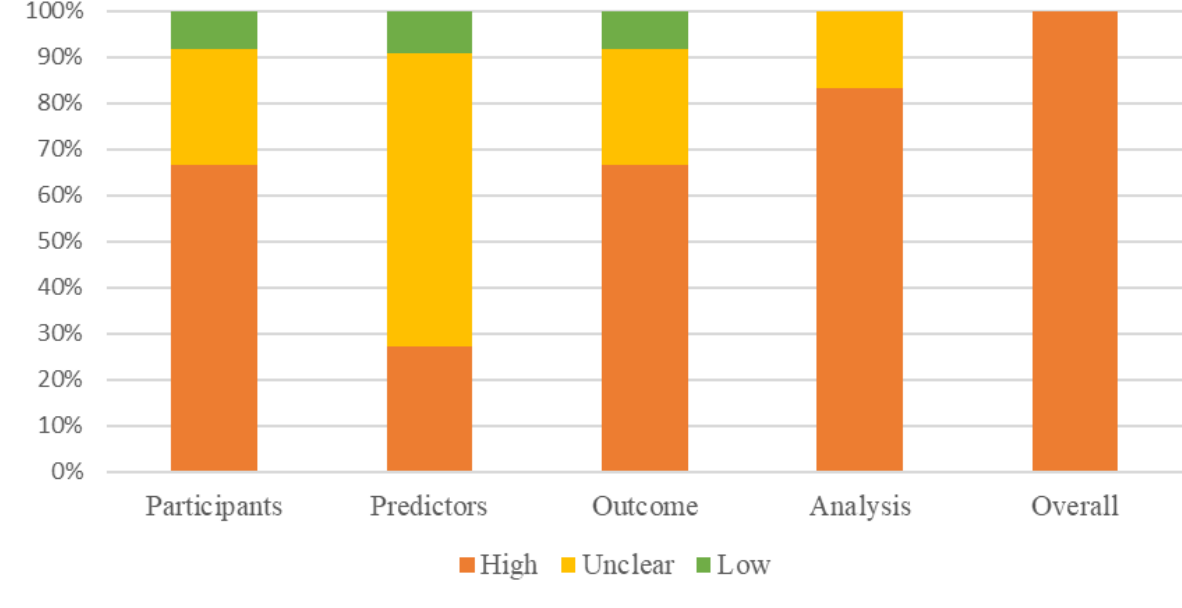
Figure 3. Risk of bias assessment for the predictive model